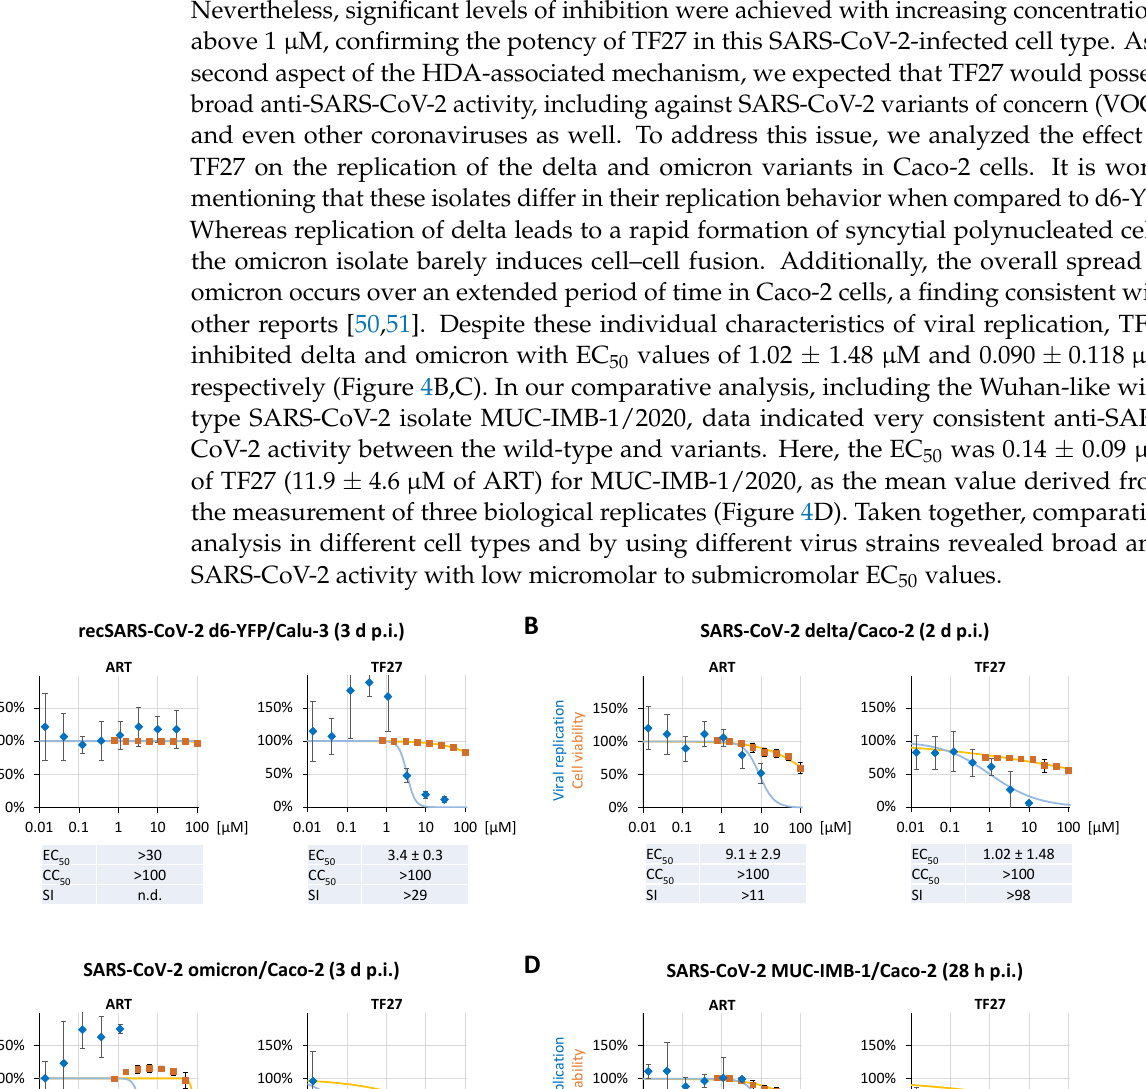
Figure 4. TF27 exerts anti-SARS-CoV-2 activity in two different human host cell types and is similarly effective against viral delta and omicron variants as well as the MUC-IMB-1/2020 isolate. ( A ) Human Calu-3 lung cells cultivated in 96-well plates at 25,000 cells per well were infected with the recombinant SARS-CoV-2 reporter virus d6-YFP at the MOI of 0.003 and treated with the indicated concentrations of compounds. At 3 d p.i., the cells were fixed using formalin and viral replication was determined by quantitation of the cell-associated YFP fluorescence. ( B ) Human Caco-2 cells cultivated in 96-well plates at 25,000 cells per well were infected with the SARS-CoV-2 delta variant; ( C ) in parallel, Caco-2 cells were infected with the SARS-CoV-2 omicron variant. In both cases, the inoculum used had been empirically determined to achieve 75% infected cells at the time point of harvest. ( D ) Caco-2 cells cultivated in 96-well plates at 25,000 cells per well were infected with the SARS-CoV-2 MUC-IMB-1/2020 isolate at an MOI of 0.003. The infected cells were treated with the indicated concentrations of compounds. At 2 d p.i. (delta), 3 d p.i. (omicron), or 28 h p.i. (MUC-IMB-1/2020), the cells were fixed using formalin and viral replication was determined by staining with the monoclonal antibody recognizing the SARS-CoV-2 nonstructural protein 3 (delta and omicron) or the viral spike protein (MUC-IMB-1/2020) followed by incubation with a fluorescently labeled secondary antibody. Viral replication was assessed by quantitation of the cell-associated fluores- cence. Cell viability was measured for each infection setting using parallel cultures of uninfected cells from the respective cell type incubated with ART or TF27 for a duration matching at least the period of replication. Cell viability was determined by Neutral Red assay (NRA). The values repre- sent means ± SD of the biological quadruplicates (replication) or triplicates (NRA). 3.4. TF27 Exhibits Synergistic Interaction with GC376 but Antagonistic Interaction with EIDD- 1931 Viral resistance formation represents a general problem when dealing with DAAs, which can be prevented by antiviral drug combination therapy. In the case of using two or more drugs, more pronounced antiviral activities are achievable. This reveals true syn- ergistic antiviral activity which is defined by a combined effect that exceeds the sum of activities exerted by the corresponding single drugs. Interestingly, several reports have already described the promising synergistic drug interactions of ART with diverse anti- HCMV agents in vitro [52–58]. To investigate if TF27 exhibits synergism with approved as well as experimental SARS-CoV-2 antivirals, TF27 ′ s drug interactions were analyzed by applying the Loewe additivity fixed-dose assay according to previously established protocols for SARS-CoV-2 infection [22]. As combination partners for TF27, EIDD-1931 (the active metabolite of molnupiravir), and GC376, (as a representative of 3CLpro-tar- geted protease inhibitors) were analyzed. These two drugs were selected based on their